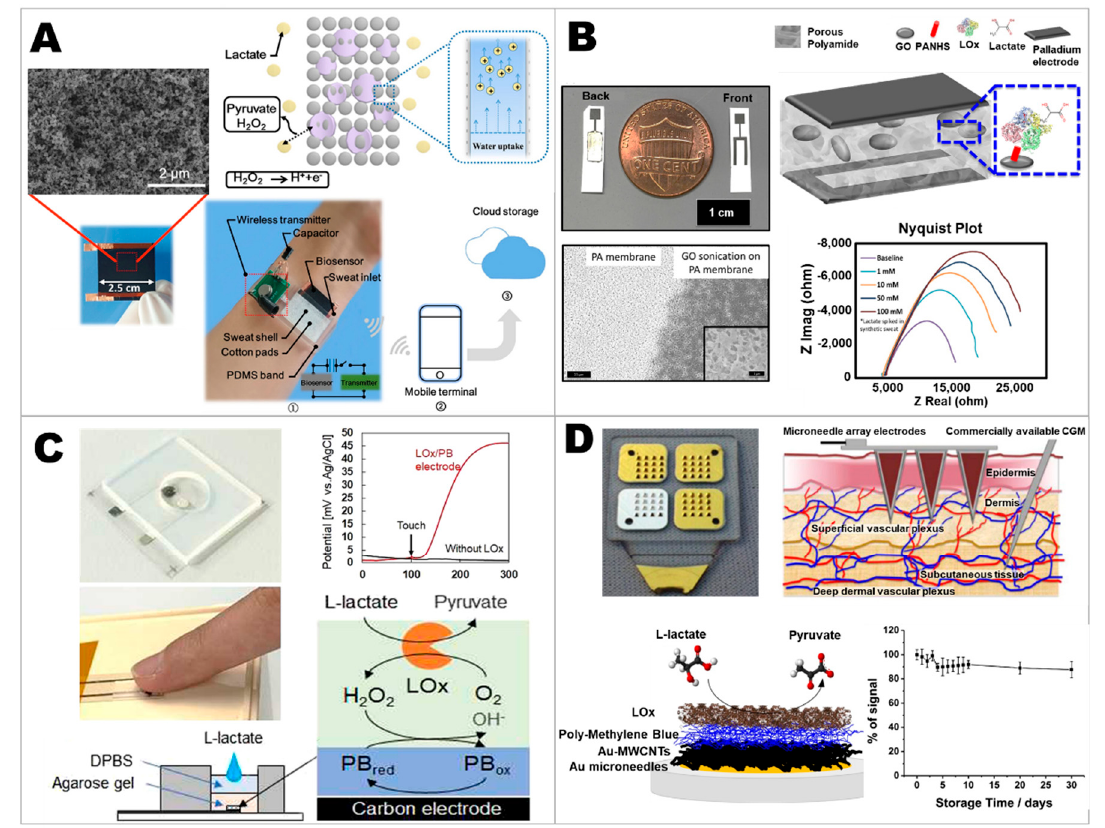
Figure 4. Examples of lactate sensors. ( A ) Self-powered lactate sensors. Adapted with permission from [98], copyright 2019, Elsevier. ( B ) Flexible graphene oxide-based lactate sensors. Adapted with permission from [99], copyright 2020, Elsevier. ( C ) Potentiometric lactate sensors. Adapted under the terms and conditions of the CC-BY 4.0 from [100], copyright 2019, Nagamine et al., published by Sci. Rep. ( D ) Microneedle-based lactate sensors. Adapted with permission from [101], copyright 2019, Elsevier.